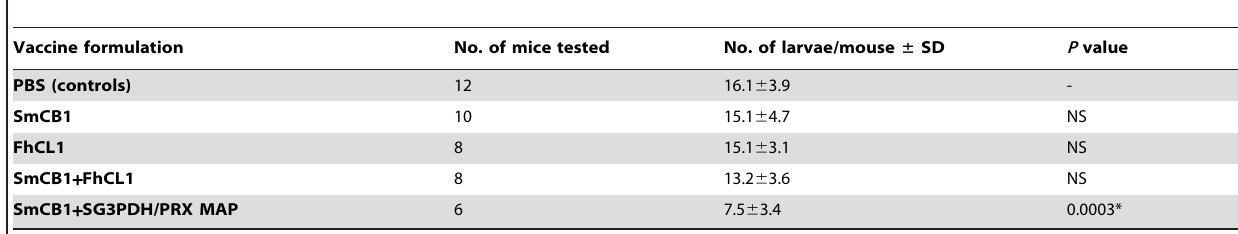
Table 2. Recovery of lung-stage schistosomules from unimmunized and immunized mice 6 days after the challenge infection.